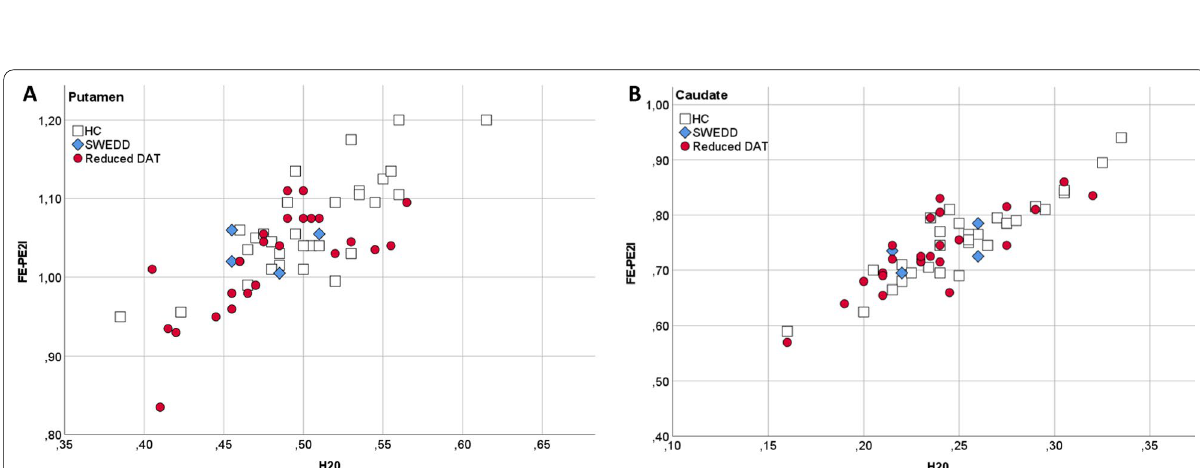
Fig. 3 Voxelwise correlations between R1 and F for healthy controls and patients. Legend Correlations, r , between R1 and F are shown on the cortical surface (https:// www. human conne ctome. org/ softw are/ conne ctome- workb ench) for healthy controls and patients. High correlations are shown in orange and red color; medium to high correlations are shown in green and yellow